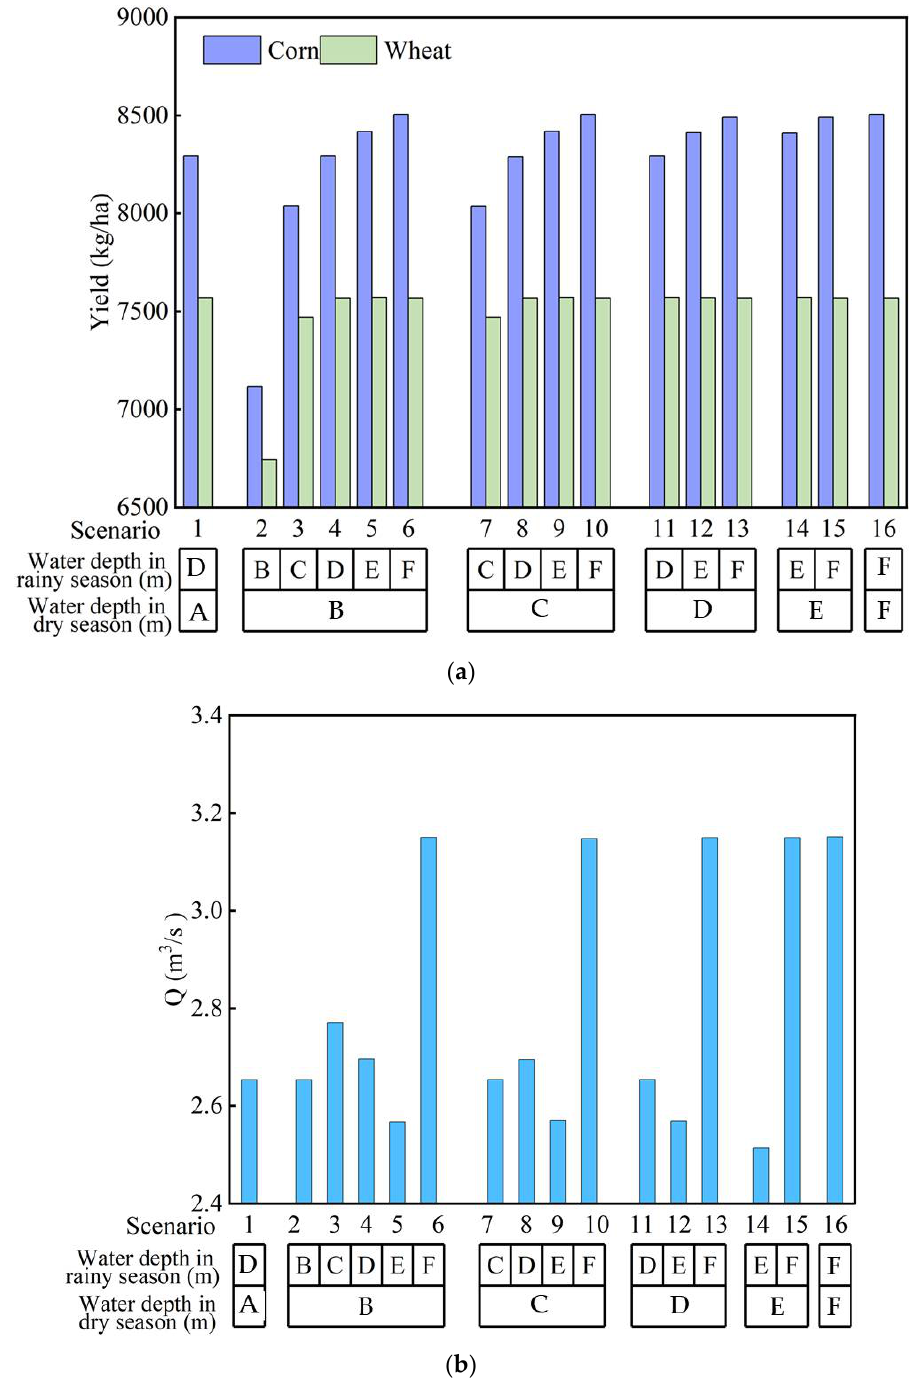
Figure 4. Changes in evaluation indexes under different main ditch water depth control